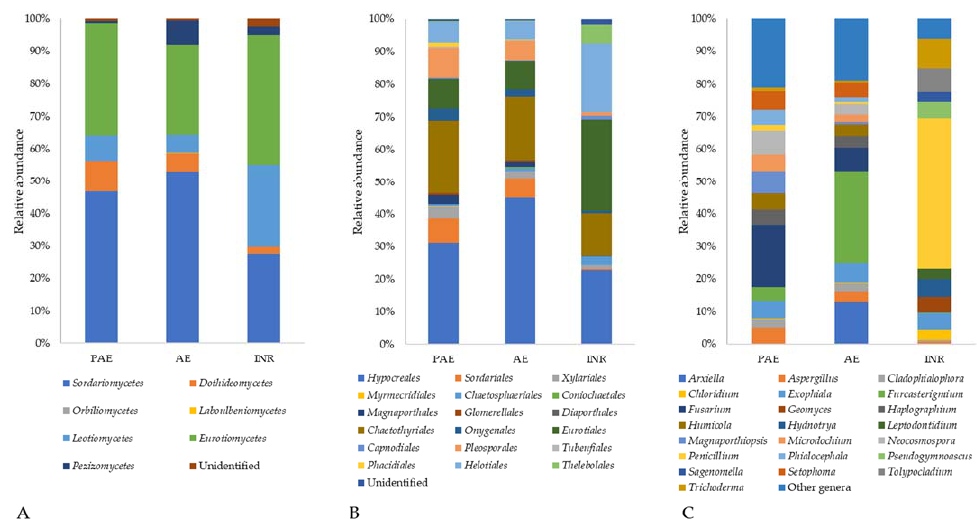
Figure 4. Relative abundances of Ascomycota classes ( A ), orders belonging to the most represented classes of Ascomycota ( Sordariomycetes , Eurotiomycetes , Leotiomycetes, and Dothideomycetes ) ( B ), and the most abundant genera ( C ) in soil samples taken from the Polluted AgroEcosystem (PAE), the AgroEcosystem (AE), and the integral natural reserve (INR).